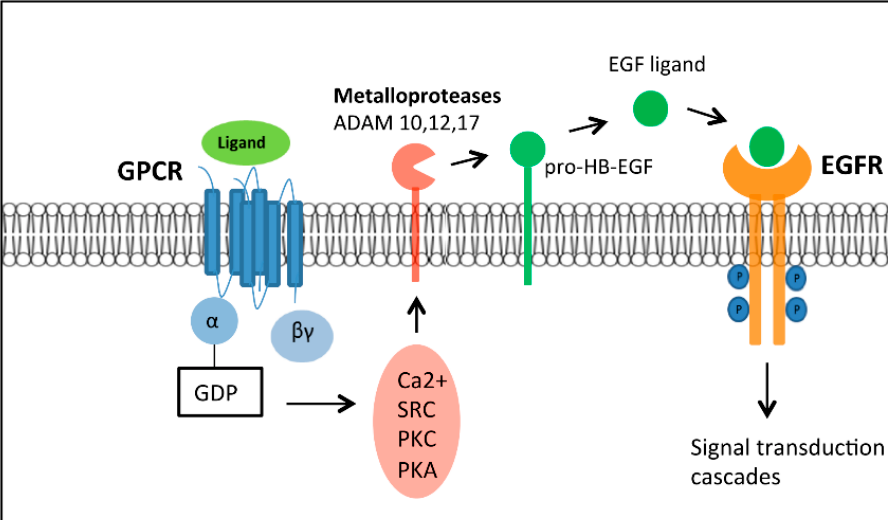
Figure 4. GPCR-mediated transactivation of EGFR. GPCRs induce the transactivation of EGFR through several mediators, including SRC kinases, Ca 2+ , PKC and PKA [133]. GPCR stimulation leads to activation of several members of the ADAM family of metalloproteases that generates the mature EGFR ligand from pro-HB-EGF. The release of the mature growth factor activates the EFGR and its subsequent downstream signaling cascades including activation of the mitogen-activated protein kinase (MAPK) transduction pathway controlling cell proliferation [135]. Adapted from [141].